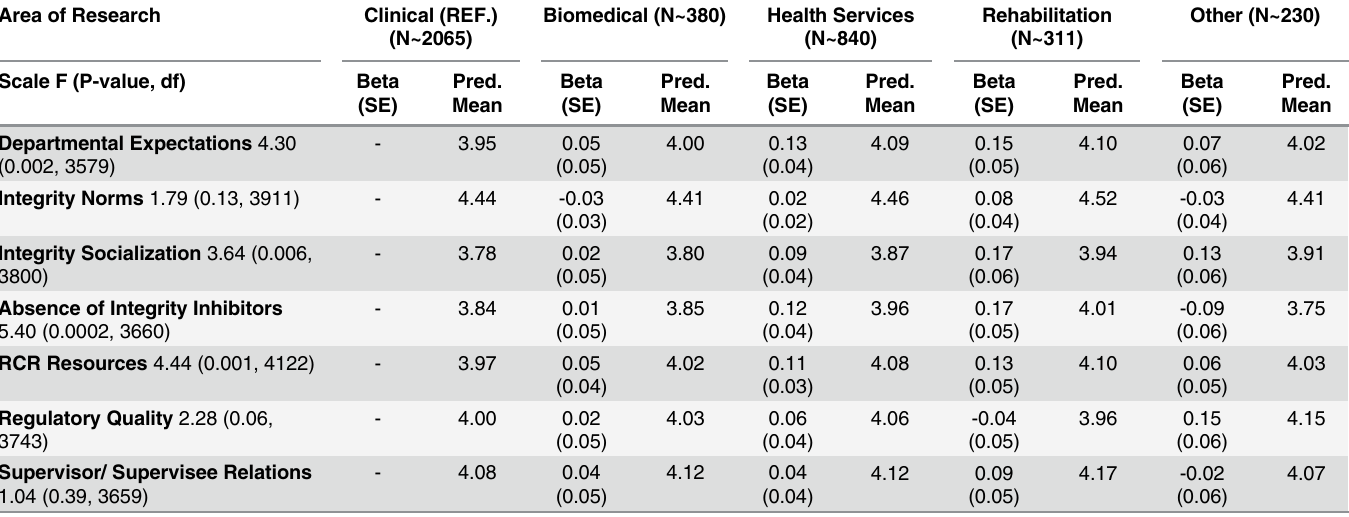
Table 5. Generalized Linear Mixed Model Regressions of SOURCE scales by respondent characteristic of primary research area. Area of